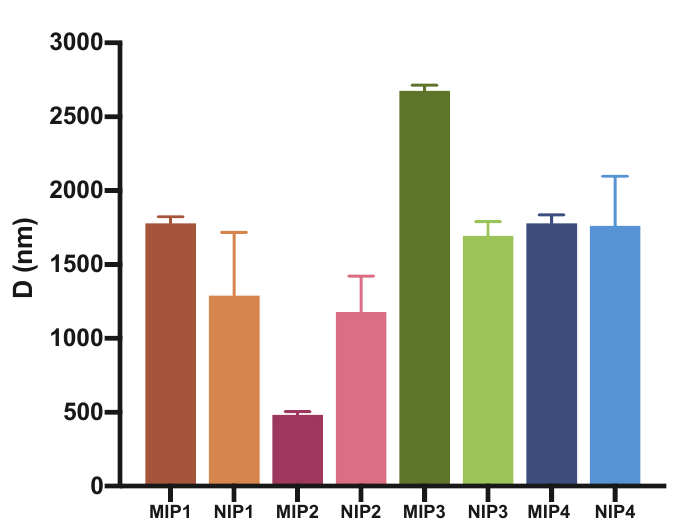
Figure 4. Average hydrodynamic diameter evaluated by DLS.